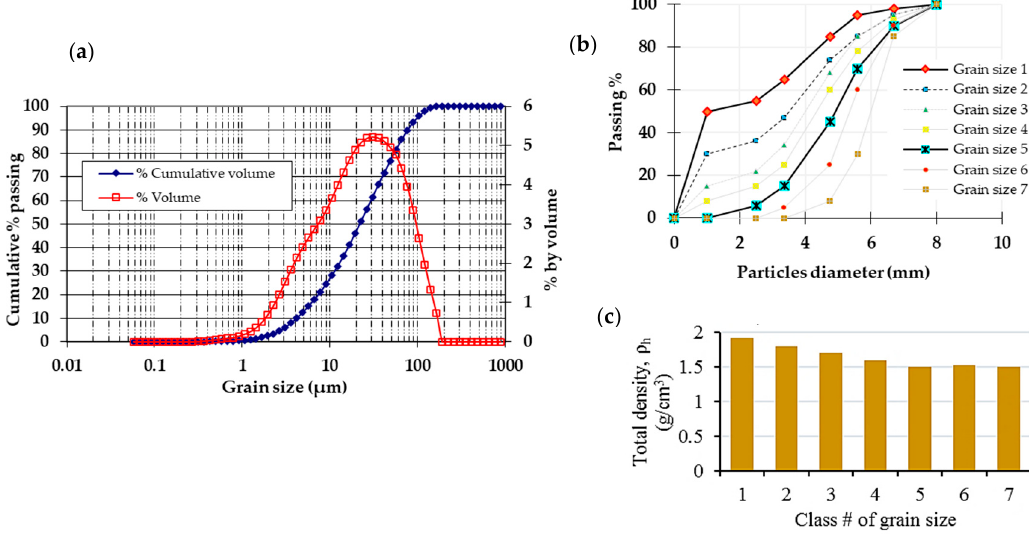
Figure 3. Material characteristics: ( a ) grain size distribution (GSD) curve of the mine tailings sample, ( b ) particles’ size distribution curves of the waste rock barricade, and ( c ) barricade total or bulk density as a function of the particle size distribution curve number (from #1 to #7).